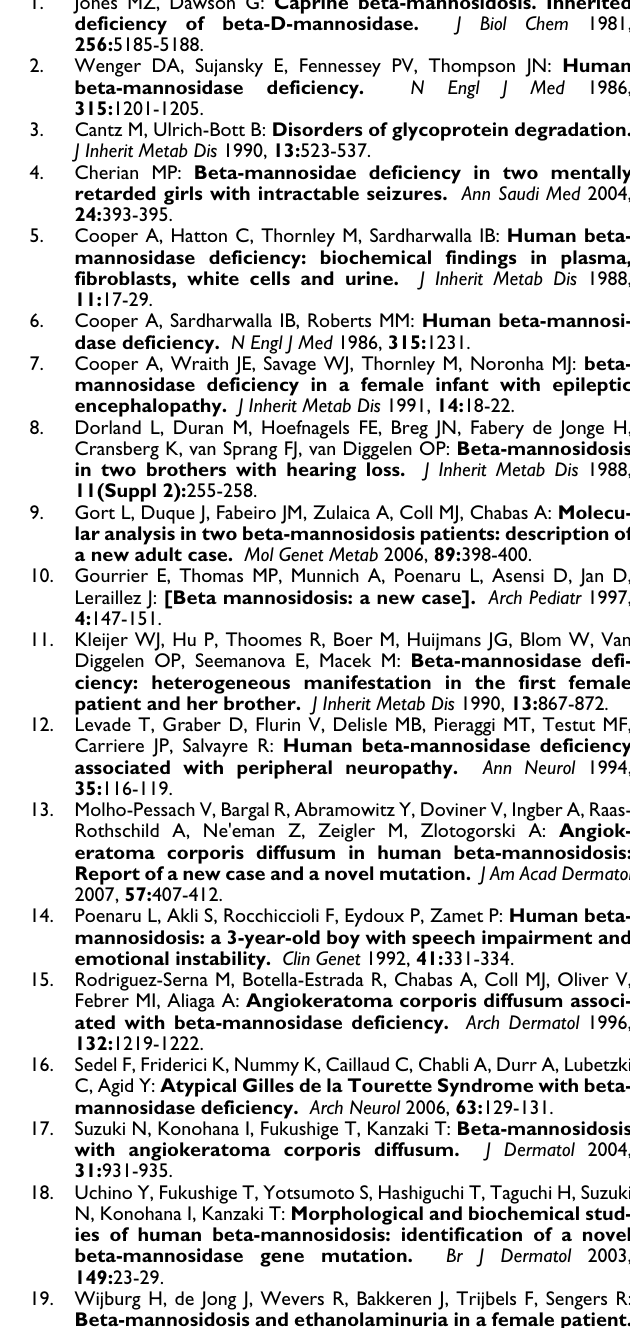
Table 2 . Residual enzyme activity of β -mannosidase and clinical pheno- type associated by MANBA mutations. Click here for file [http://www.biomedcentral.com/content/supplementary/1471-